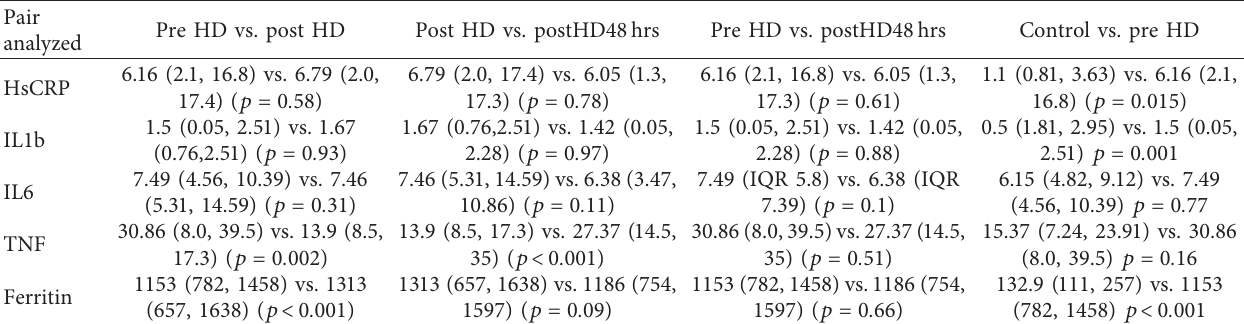
Table 3: Inflammatory markers before HD (preHD), after HD (postHD), and 2 days later